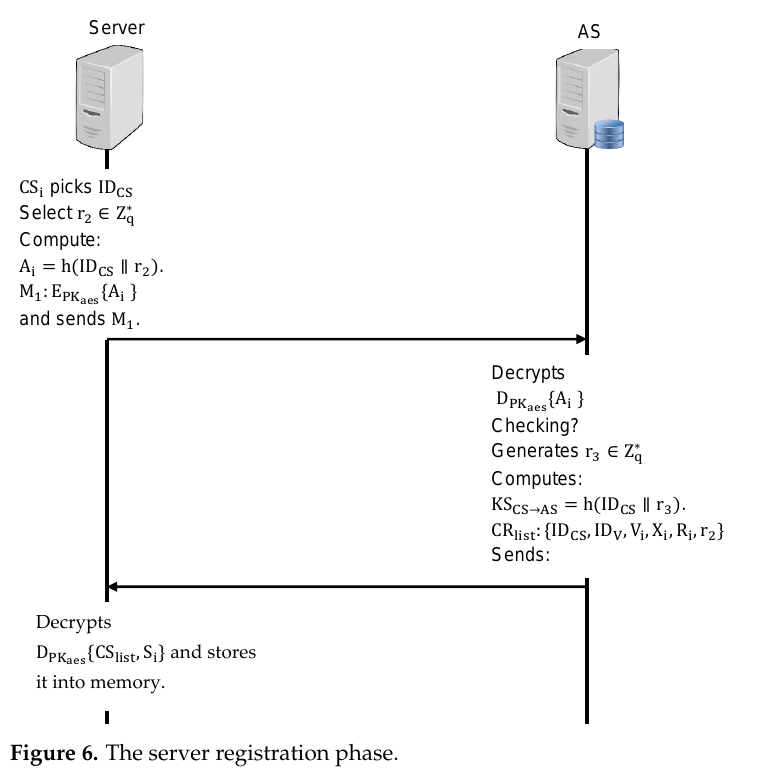
Figure 6. The server registration